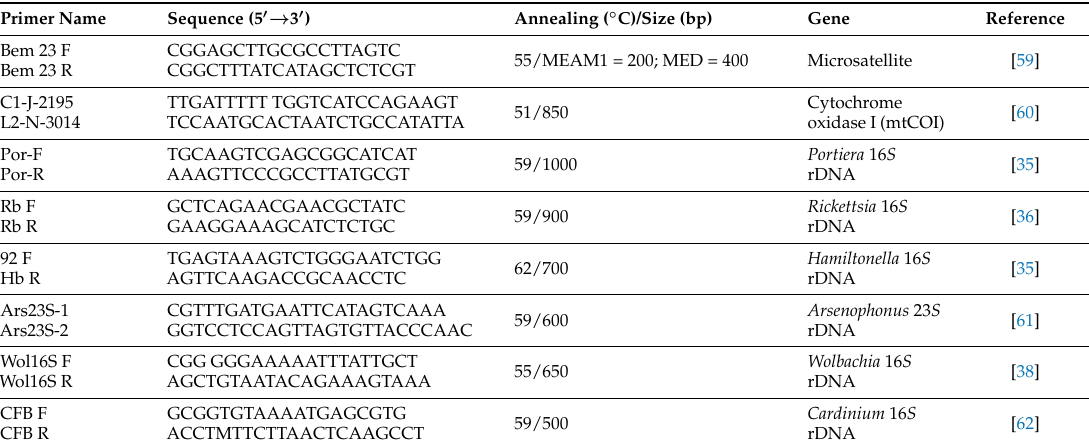
Table 1. The primers used in this